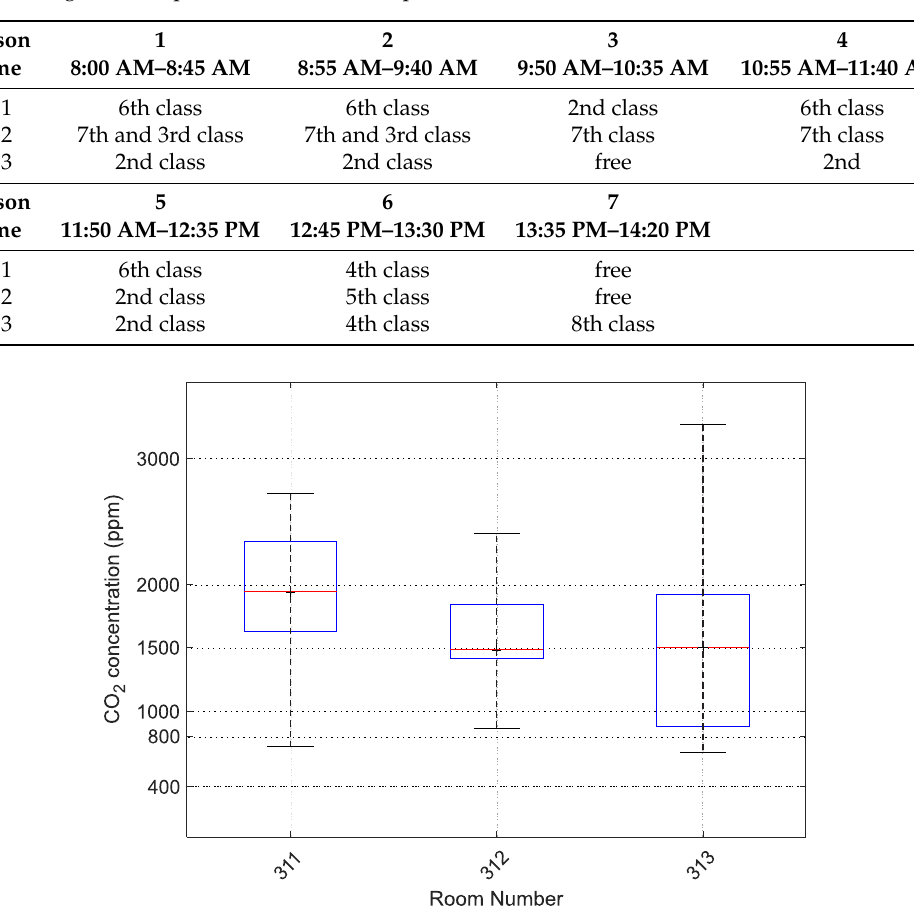
Figure 15. Boxplot for classrooms 311, 312 and 313 on 15 January 2019, Grammar School and Secondary School of Electrical Engineering and Computer Science, Frenštát pod Radhoštˇem.